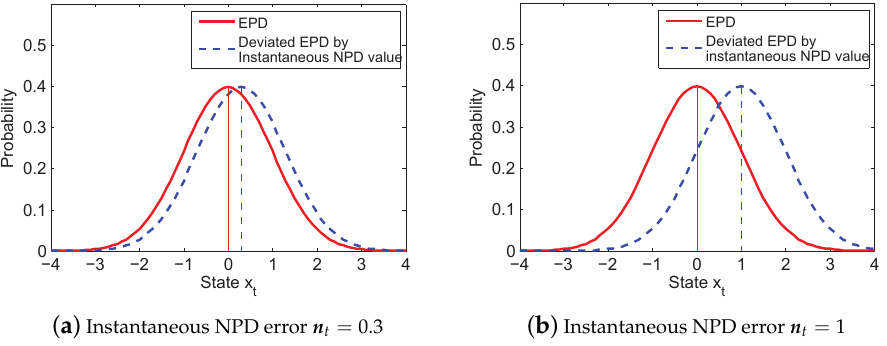
Figure 2. Example: the two likelihood functions. The solid curve represents the expected parametric distribution (EPD), and the dashed curve represents the deviated likelihood function by the instantaneous non-parametric distribution (NPD)